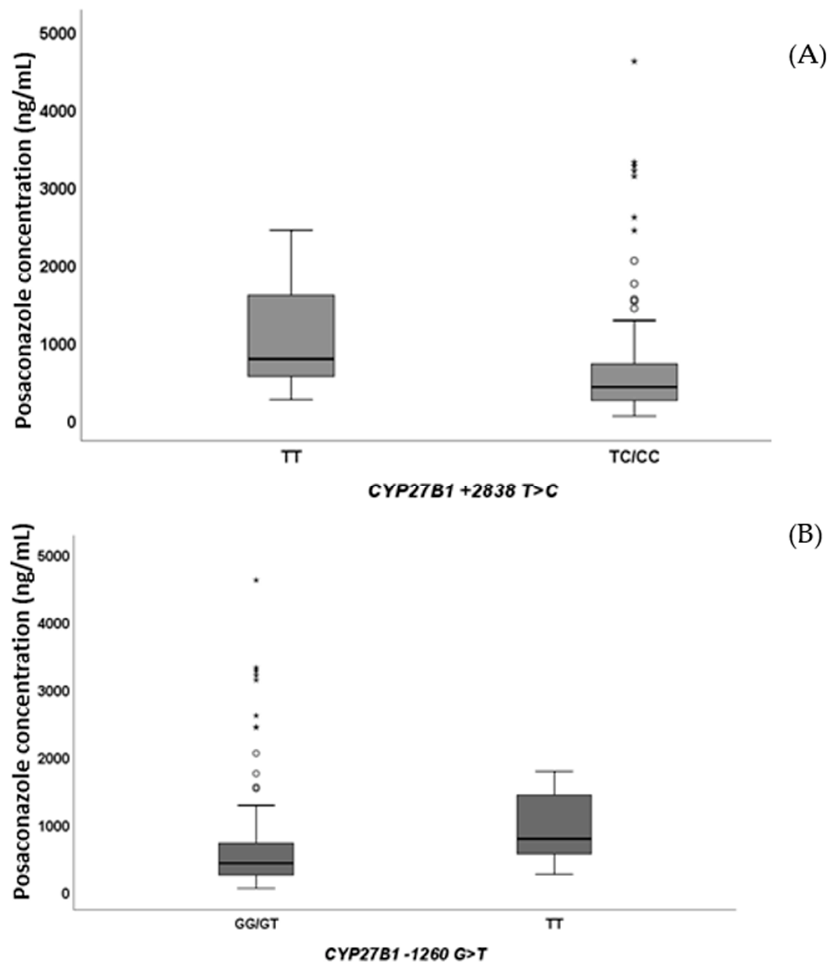
Figure 2. CYP27B1 + 2838 T > C (( A ), p = 0.038) and CYP27B1 − 1260 G > T (( B ), p = 0.004) SNPs influence on posaconazole exposure. Outliers are represented by little circles, and extreme outliers are represented by little